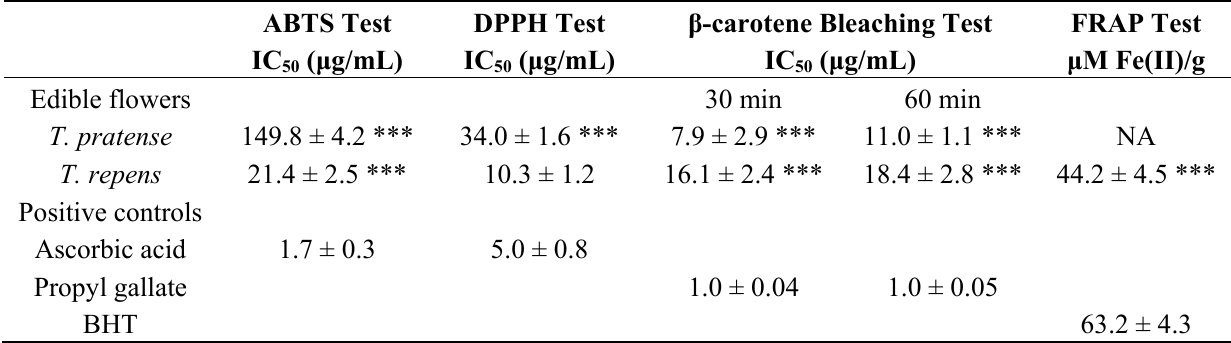
Table 2. Antioxidant activity of white and red clover flowers